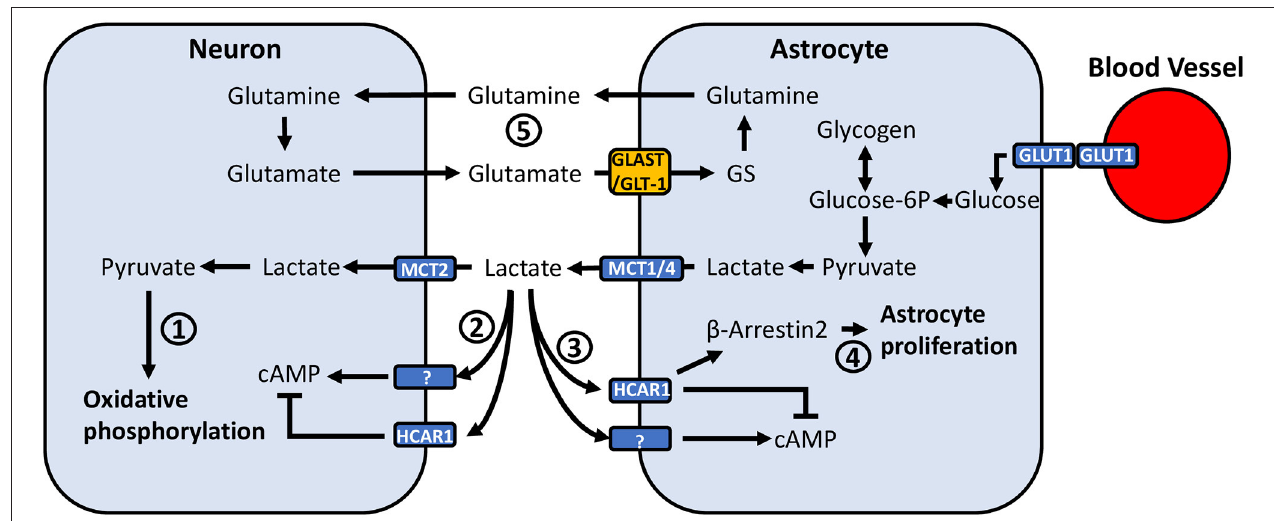
FIGURE 2 | Potential mechanisms through which astrocyte-neuronal metabolic coupling and lactate release can mediate pain-related neuronal activity. (1) Lactate taken up by neurons via MCT2 is converted to pyruvate, where it can be used to generate ATP through oxidative phosphorylation. (2) Neurons express HCAR1, a G i -protein coupled receptor which inhibits adenylyl cyclase and reduces intracellular cAMP. Neurons also appear to express an unidentified lactate receptor which activates adenylyl cyclase and increases cAMP. (3) Similarly, astrocytes have been found to express HCAR1, however recent findings also suggest the presence of a lactate receptor which exerts opposite effects and activates rather than inhibits adenylyl cyclase. (4) Lactate binding to HCAR1 was recently associated with a non-G i -protein mechanism, acting through β -arrestin2-MAPK-signaling. The β -arrestin2-MAPK pathway has been associated with induction of astrocyte proliferation. (5) Glutamate released into the synaptic cleft is taken up by astrocytes via GLT-1 and GLAST. Astrocytic GS converts glutamate to glutamine, which is exported and taken up by neurons. Altered GLT-1/GLAST expression may affect synaptic transmission through dysregulation of extracellular glutamate